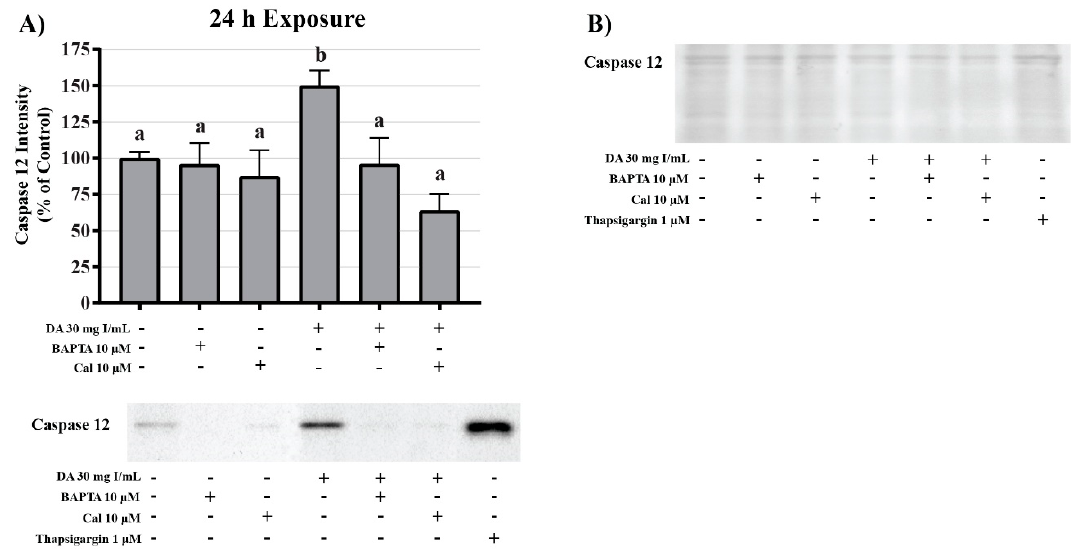
Figure 22. Effects of BAPTA-AM or calpeptin pretreatment on caspase 12 activity in HK-2 cells. Pretreatment with BAPTA-AM or calpeptin abrogated caspase 12 activation. Representative blots and cumulative densitometry included for caspase 12 ( A ) following 24 h exposure to DA. Representative blot with Memcode reversible stain for 40 µg loaded protein ( B ). Positive control for caspase 12 activation was thapsigargin. Different superscripts (a,b) indicate a statistical difference ( p < 0.05) between various groups. Values represent mean ± SEM for three independent experiments.